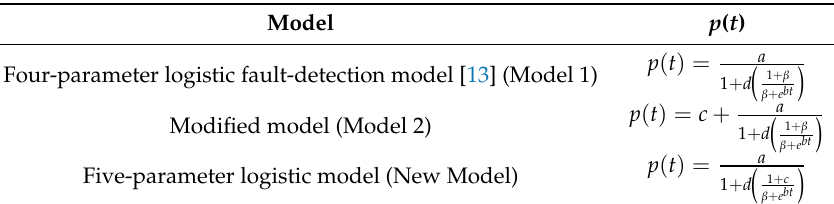
p ( t ) = a (cid:18) (cid:19) 1 + β 1 + d β + ebt p ( t ) = c + a (cid:18) (cid:19) 1 + β 1 + d β + ebt p ( t )